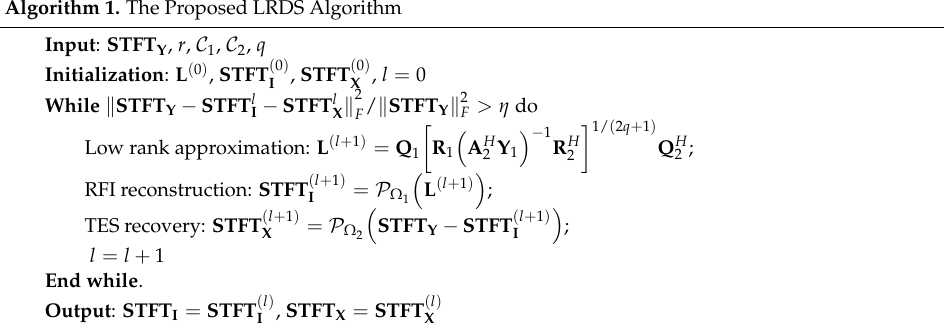
Algorithm 1. The Proposed LRDS